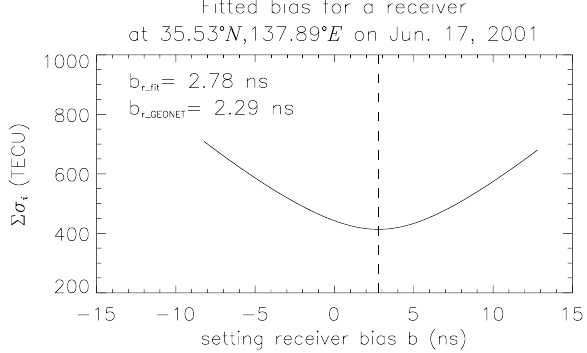
Fig. 9. Slant path TEC sl (dash lines) from GPS satellites to a receiver at 35.53 ◦ N, 137.89 ◦ E. The solid lines are vertical TEC converted from TEC sl with the instrumental biases removed. The satellite biases are GEONET de- rived. The receiver bias is GEONET derived in the top panel. They are as- sumed values in the lower two panels. The one-day sum of the standard devia- tion of TECs to their mean at any time, 6σ , is shown in each panel.